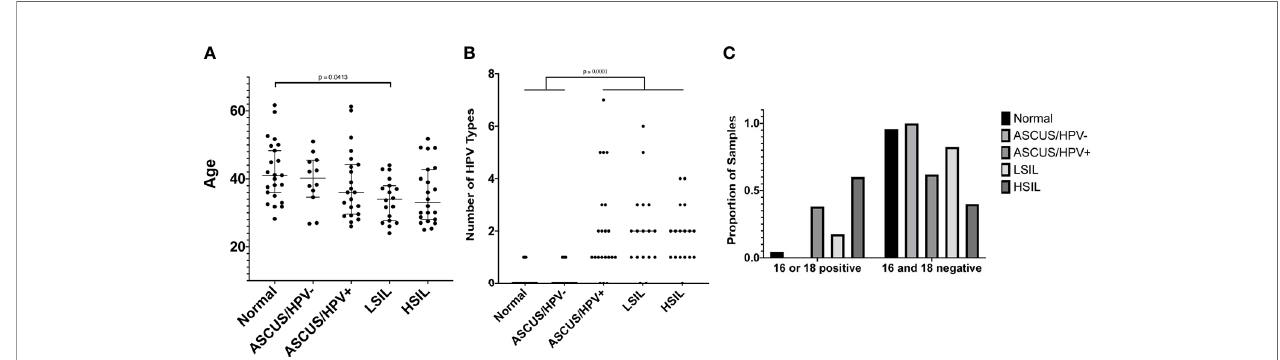
FIGURE 3 | (A) The age of women at the time the cervical sample was collected. Age was only available for 97 of the 103 women whose cervical sample was used for TCRB sequencing. Age is shown on the y-axis, and the result category, according to the cervical cytology and hrHPV test, is shown on the x-axis. A test for difference in the median value between result categories was conducted using a Kruskal-Wallis (KW) test followed by a Dunn ’ s post hoc multiple comparison test if the KW p value was ≤ 0.05. The Dunn ’ s multiple comparison-adjusted p values are reported when p ≤ 0.05. (B) The number of HPV types for which a sample tested positive using the Roche Linear Array. Only 96 of the 103 samples whose cervical sample was used for TCRB sequencing had suf fi cient DNA to also conduct HPV typing. The number of HPV types for which a sample tested positive is shown on the y-axis, and the result category, as de fi ned in (A) , is shown on the x-axis. Statistical tests were conducted and reported as in (A) . (C) The proportion of samples in each result category, as de fi ned in (A) that are positive for HPV16, HPV18, or both (left grouping) or are negative for both (right grouping), according to the Roche Linear Array. The proportion of samples is shown on the y-axis and indicated by the bar height. The result category is indicated by the bar color and legend. A Chi-square test of independence resulted in p <